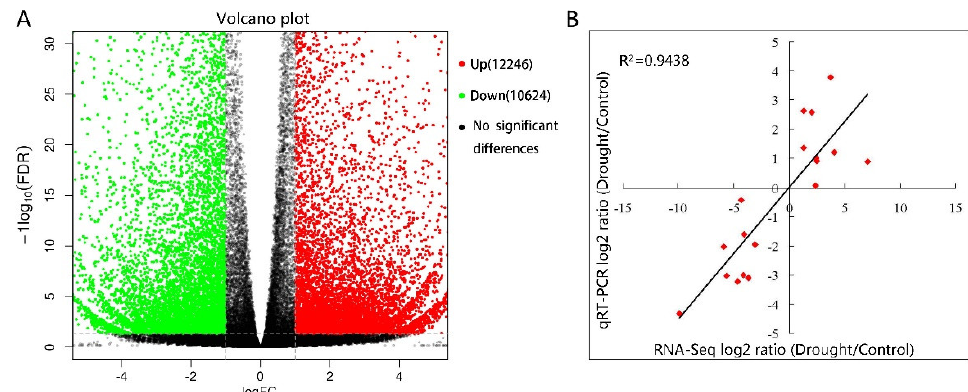
Figure 6. Analysis and validation of differentially expressed genes (DEGs) between drought-treated P. ostii and the control. ( A ) Volcano plot of DEGs. x -axis represents log2 transformed fold change; y -axis represents − log10 false discovery rate, red points represent upregulated DEGs, blue points represent downregulated DEGs, and black points represent non-DEGs. ( B ) Correlation of gene expression results obtained from RNA-Seq ( x -axis) and quantitative real-time polymerase chain reaction (qRT-PCR) ( y -axis) analysis. Correlation assay performed for 18 DEGs with log2 ratio ≥ 1.00 or ≤− 1.00. FDR, false discovery rate; FC, fold change.